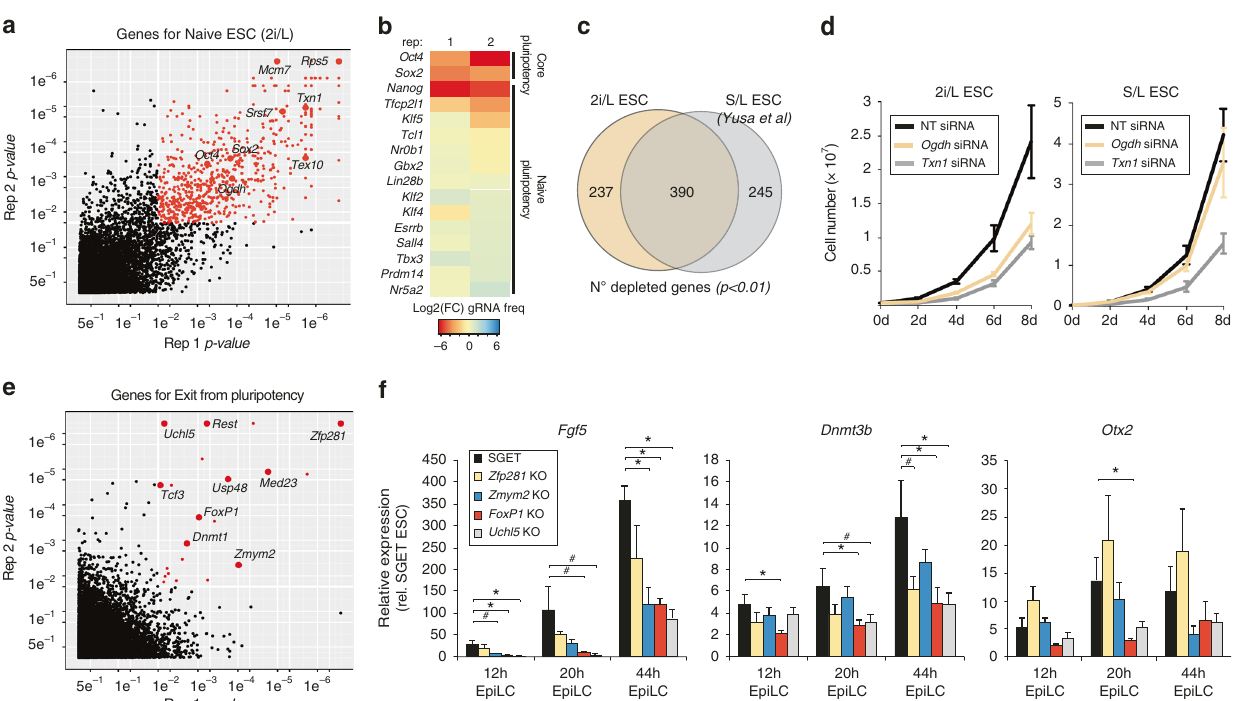
Fig. 2 Identi fi cation of important genes for ESC and EpiLC induction. a Scatter plot showing essential genes for ESC propagation in 2i/LIF (red datapoints) as determined by a CRISPR screen. b Heatmap showing mean fold change (FC) in normalised frequency of gRNAs targeting core- and naive- pluripotency genes in ESC relative to frequency in starting gRNA library. Reduced frequency indicates a functionally important gene for ESC in 2i/LIF. c Venn diagram intersecting signi fi cant depleted genes in 2i/LIF ESC (2i/L) with serum/LIF (S/L) maintained ESC. d Proliferation of ESC following siRNA knockdown of Ogdh or Txn1 in ESC maintained in 2i/L or S/L culture conditions. e Scatter plot showing signi fi cantly enriched gene knockouts in SG + ET + EpiLC that have failed to exit naive pluripotency. f Gene expression showing impaired activation of key epiblast markers in EpiLC carrying knockouts for candidate exit